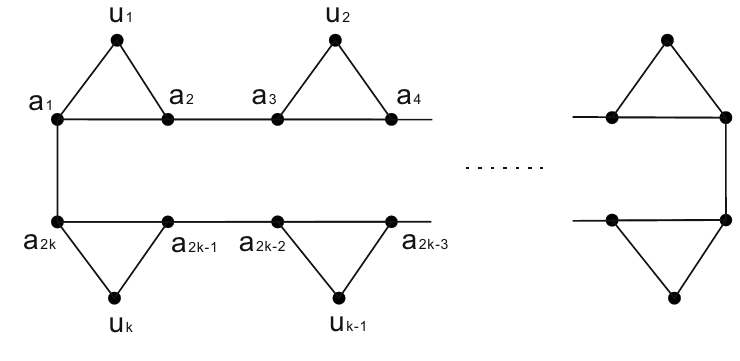
Figure 2: The graph H